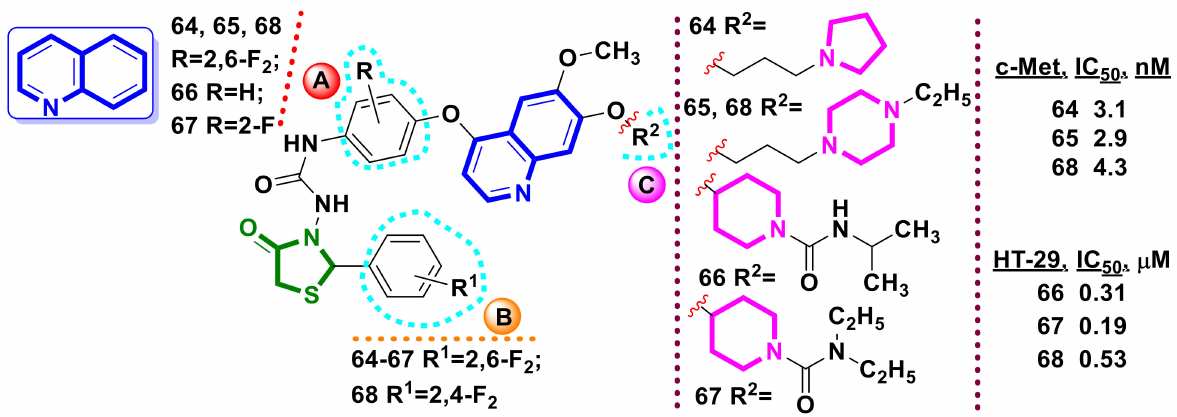
Figure 25. Quinoline-bearing hybrid molecules with 4-thiazolidinone scaffolds as potential anticancer